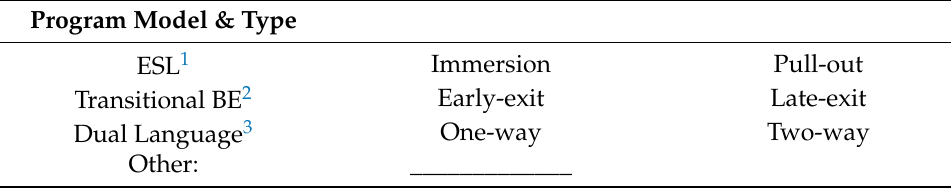
Table 5. Bilingual Program and English as a Second Language Model and